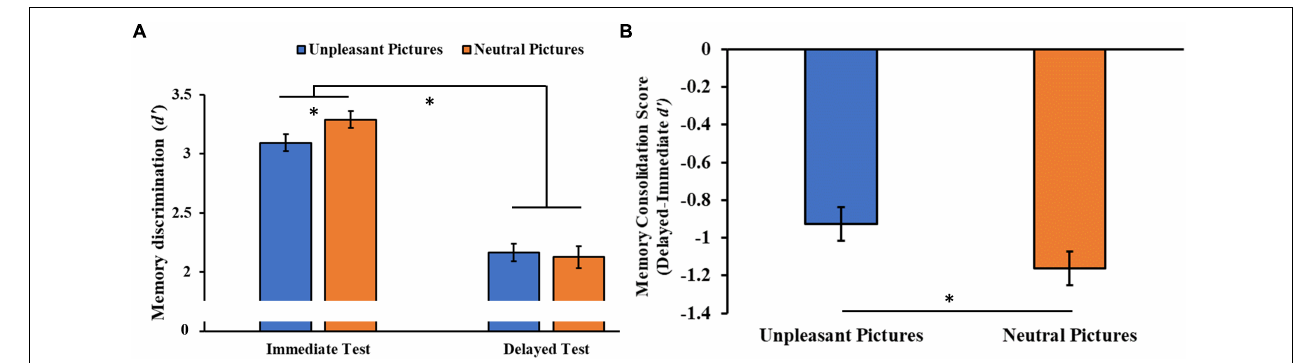
FIGURE 6 | (A) Memory discrimination ( d ’) as a function of the testing session (immediate and delayed recognition sessions) and of the type of stimuli (unpleasant and neutral pictures). (B) Memory consolidation score (delayed minus immediate test d ’ score) as a function of the type of stimuli. Error bars represent standard error of the mean. ∗ p <